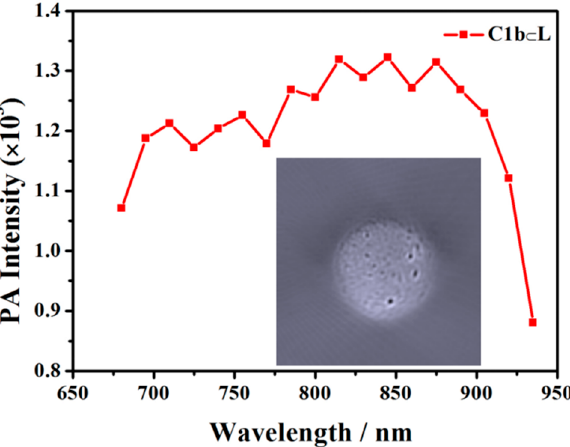
Figure 5. PA imaging of C1b ⊂ L incubated in cells and the photo of agarose gel phantom loaded with C1b ⊂ L incubated in